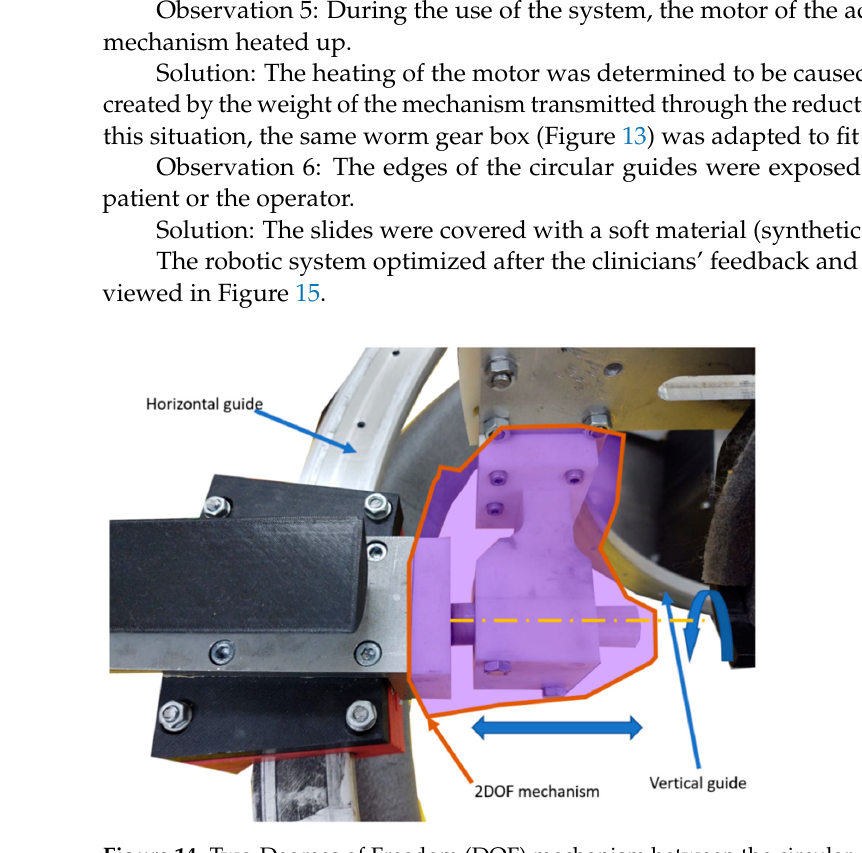
Figure 13. Worm gear (1:45 ratio CAD (Computer Aided Design) model and prototype).